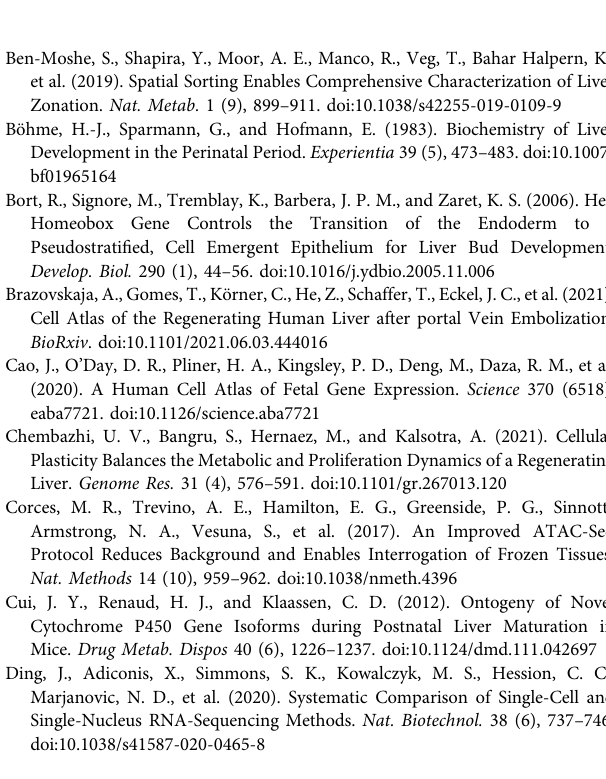
Supplementary Figure 2 | Cell-type-speci fi c marker genes expression visualized by UMAP. Supplementary Figure 3 | HSCs related ligand-receptor interaction network. SupplementaryFigure4| Cell-type-speci fi ctranscriptionfactorsregulationactivity visualized by UMAP. Supplementary Table 1 | snRNA-seq raw data